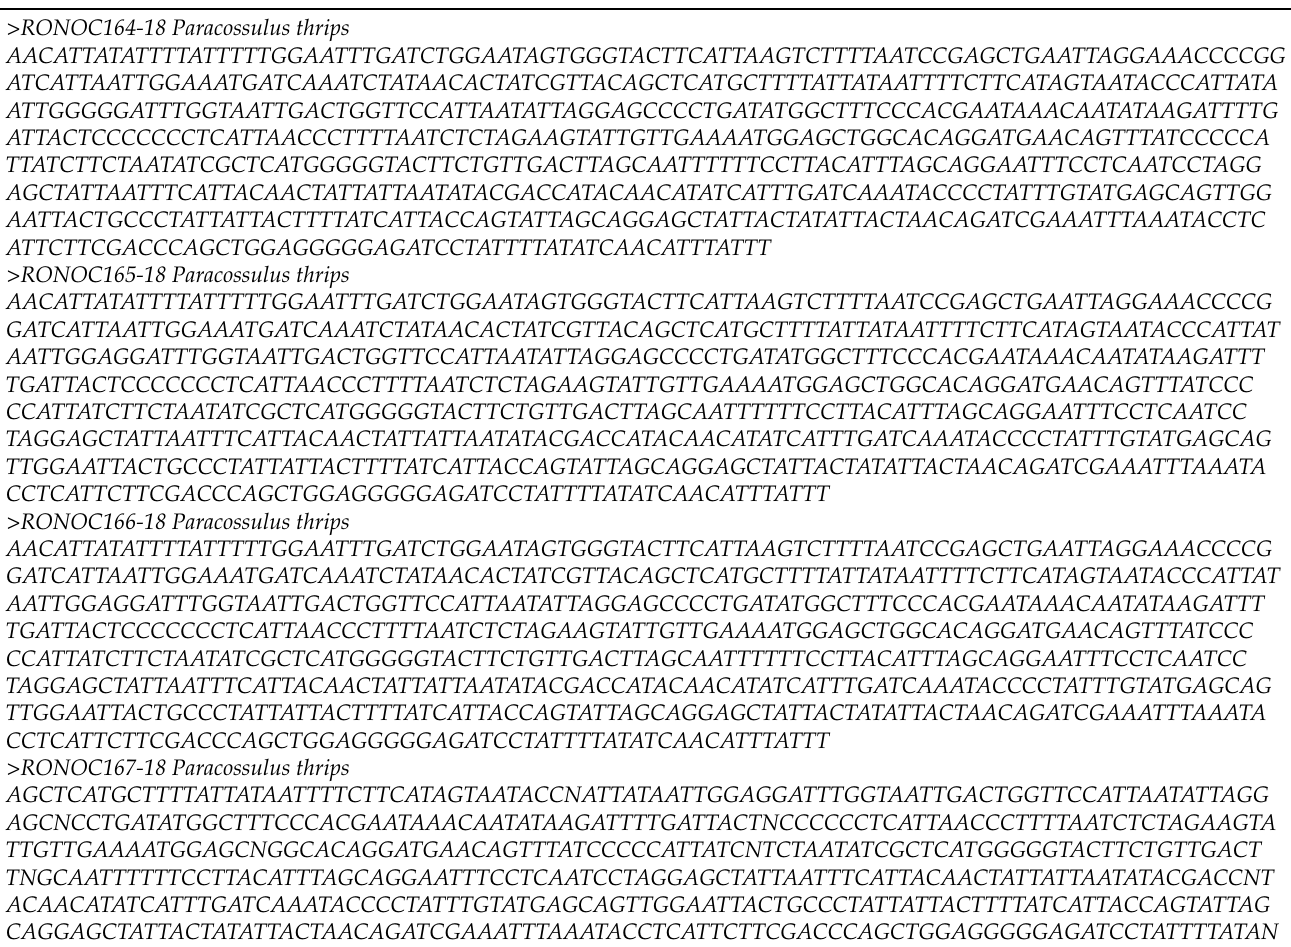
Table A3. The four CO1 sequences of Paracossulus thrips